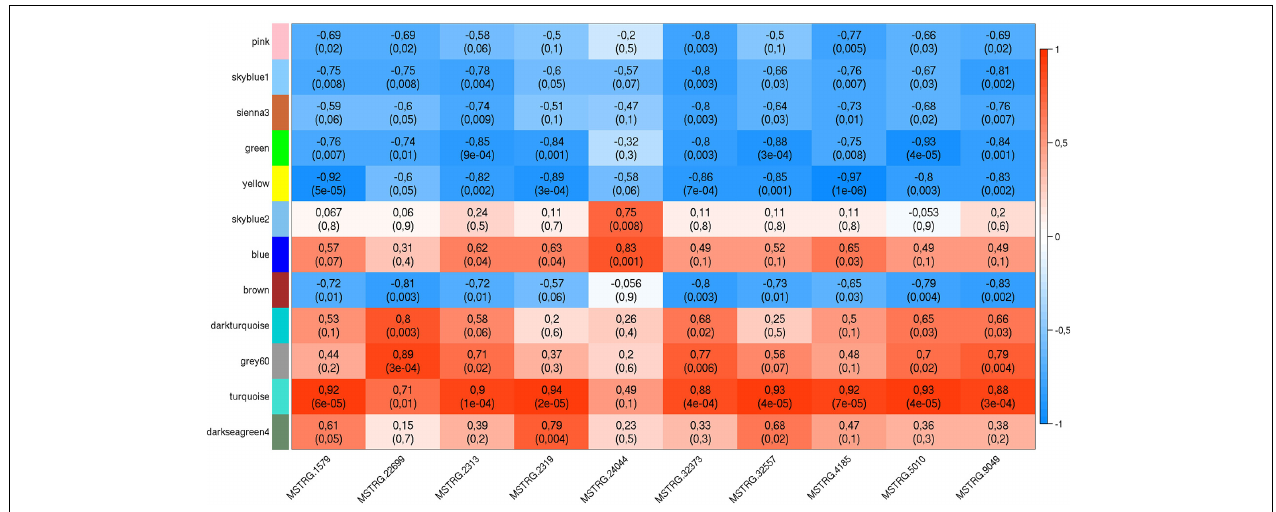
FIGURE 5 | Weighted gene co-expression plot with co-expression blocks corresponding to the significantly co-expressed ( p < 0.01) gene network modules (GNMs) (on the left ) and the 10 selected DE lncRNAs (on the bottom ). The left axis consists of color codes of each GNM, the right axis is the correlation coefficient ( r ) reference scale with integer value and color intensity (red to blue) adopted for each lncRNA and GNM block. Each block consists of correlation coefficient (on the top ) and p-value (in brackets) corresponding to each GNM-lncRNA